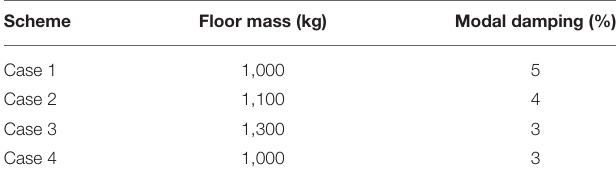
Frontiers in Built Environment |